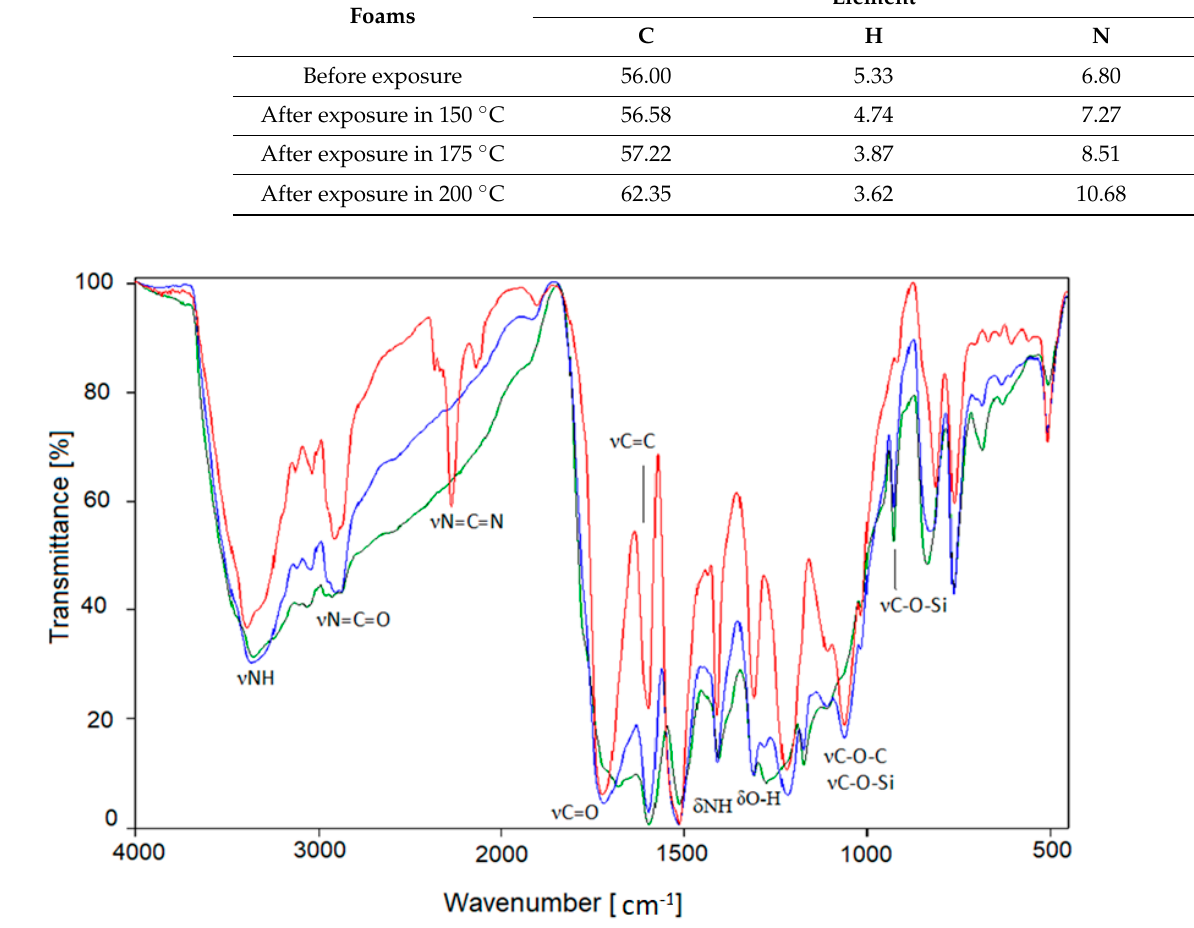
Table 10. Changes in the elemental composition of the foam during its heating.